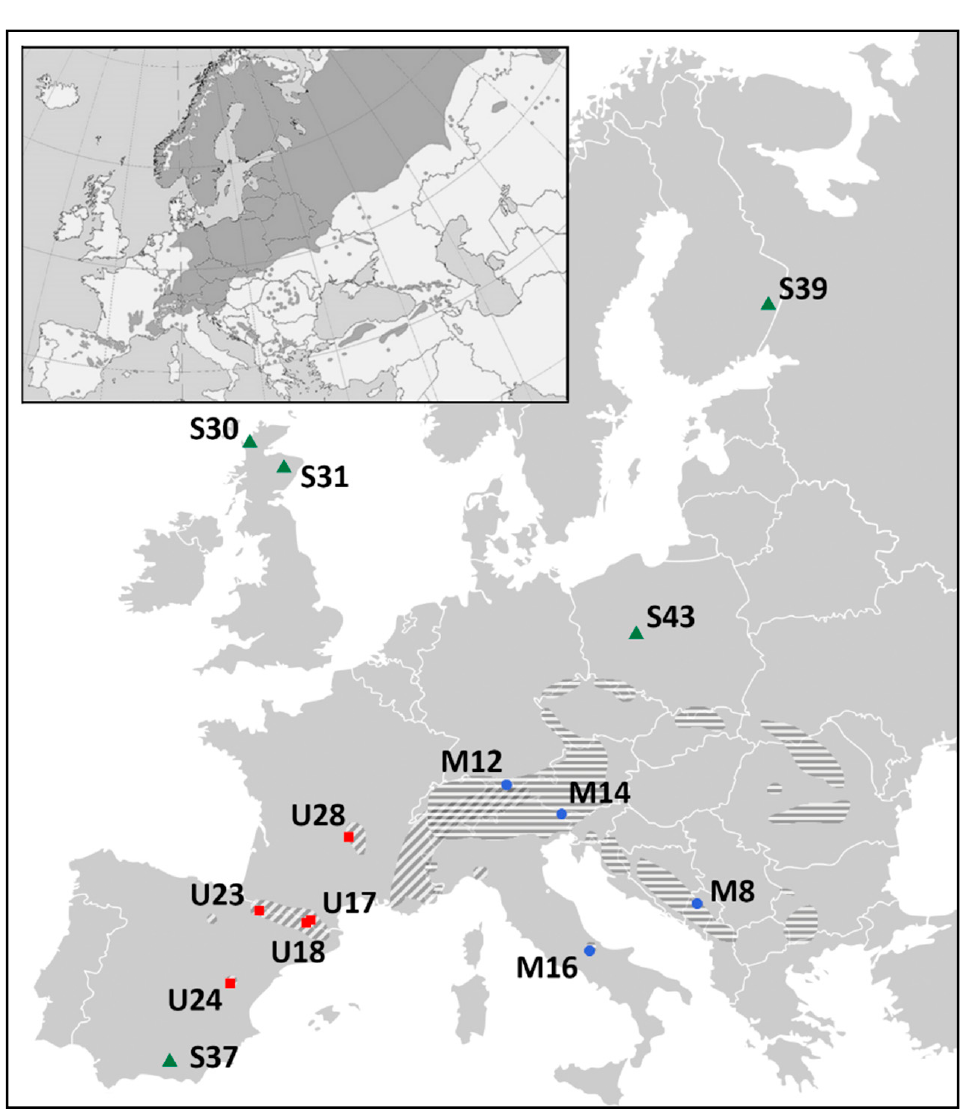
Figure 1. Localization of 14 studied populations with indication of species distributions. Dwarf pine—blue dots and horizontal shading, Pyrenean pine—red squares and diagonal shading, Scots pine—green triangles and dark shading on attached miniature presenting species’ European range.